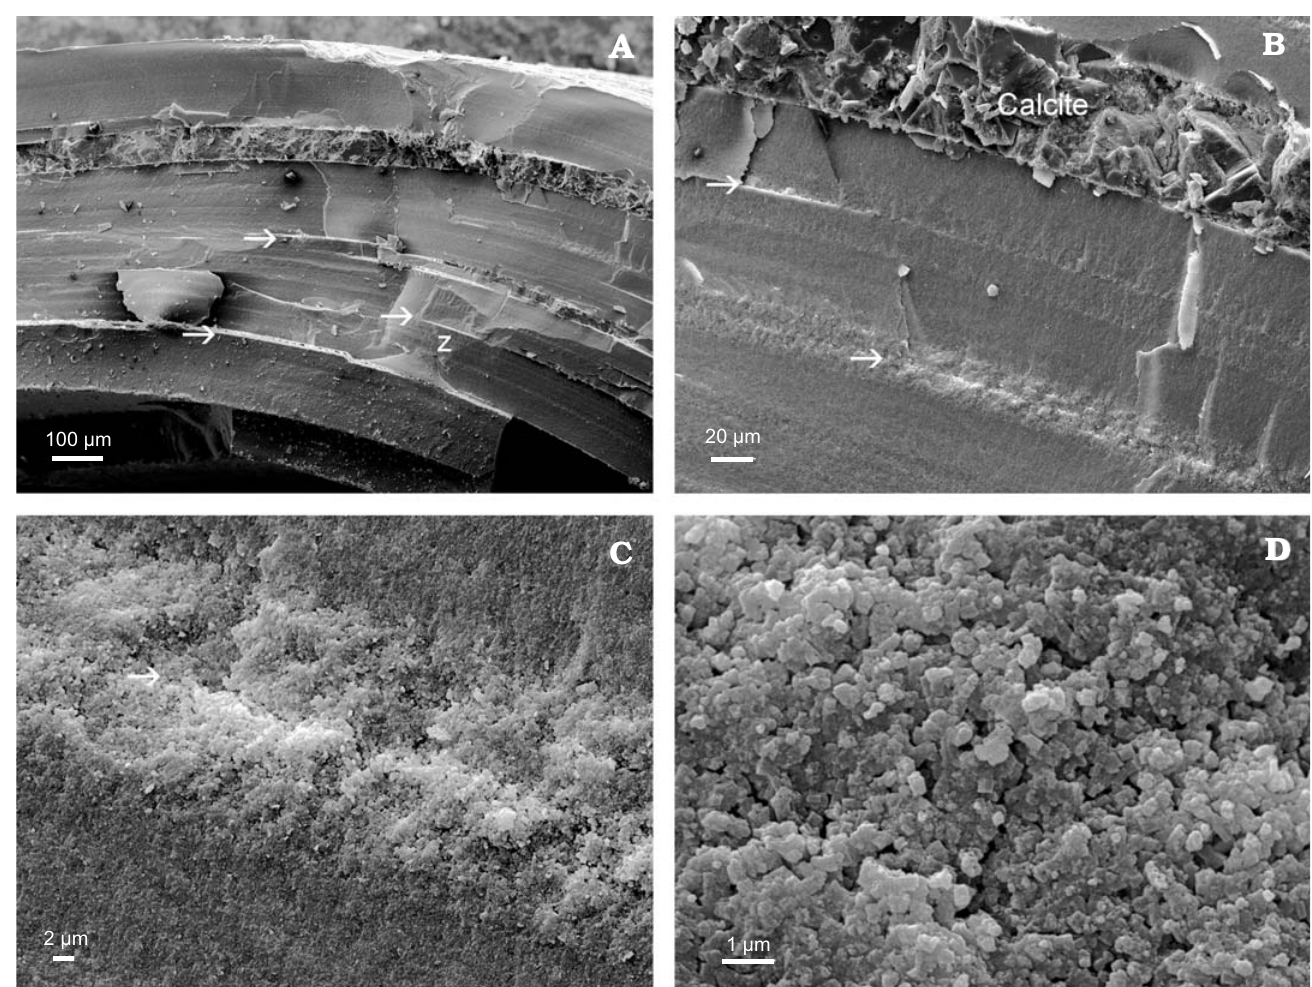
Fig. 3. Tube microstructure of Sphenothallus aff. longissimus (TUG 1648-2), Viivikonna Formation, lowermost Sandbian, Kohtla-Nõmme. A . Laminar micro structure, arrows point to the boundaries of laminae; z, possible thin primary lamination. B . Secondary calcitic layer in the tube wall, arrows point to the boundaries between laminae. C . Detail view of the boundary between laminae. D . Homogeneous